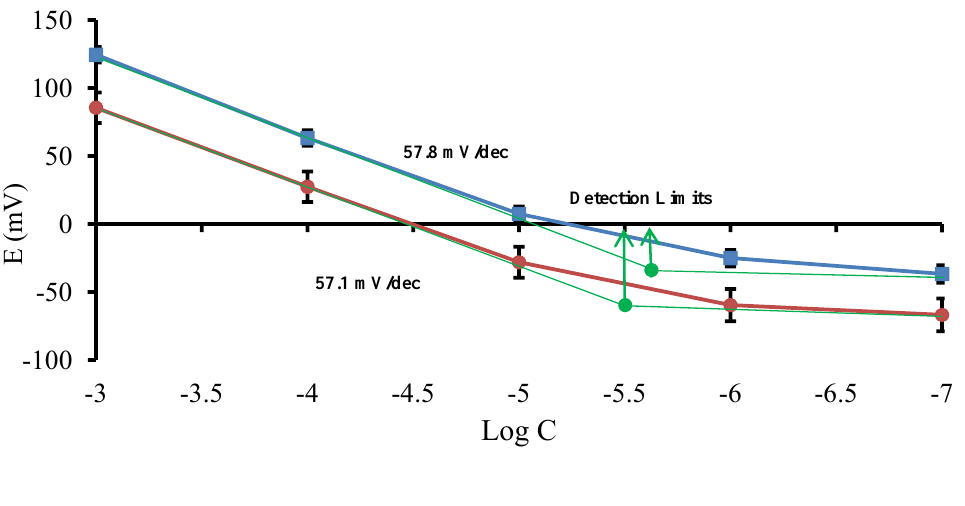
Figure 2. Comparison of the calibration plots after 4 weeks of conditioning in propranolol hydrochloride ( ■ ) and lidocaine hydrochloride ( ● ). Mean ± SD values are shown ( n =